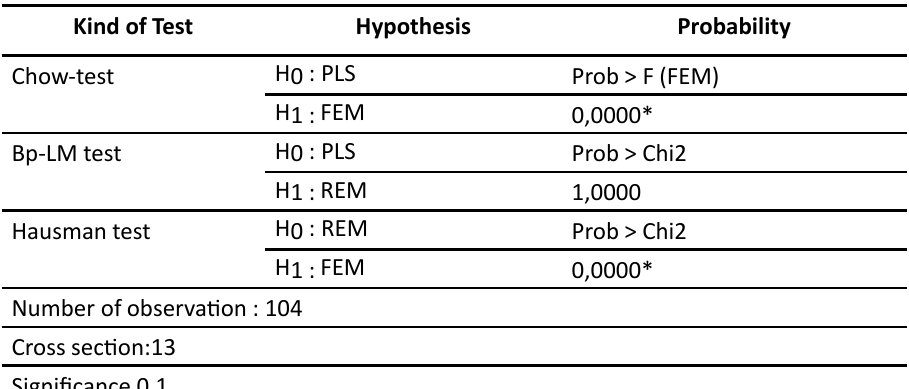
Table 1: Results of Testing Model 1